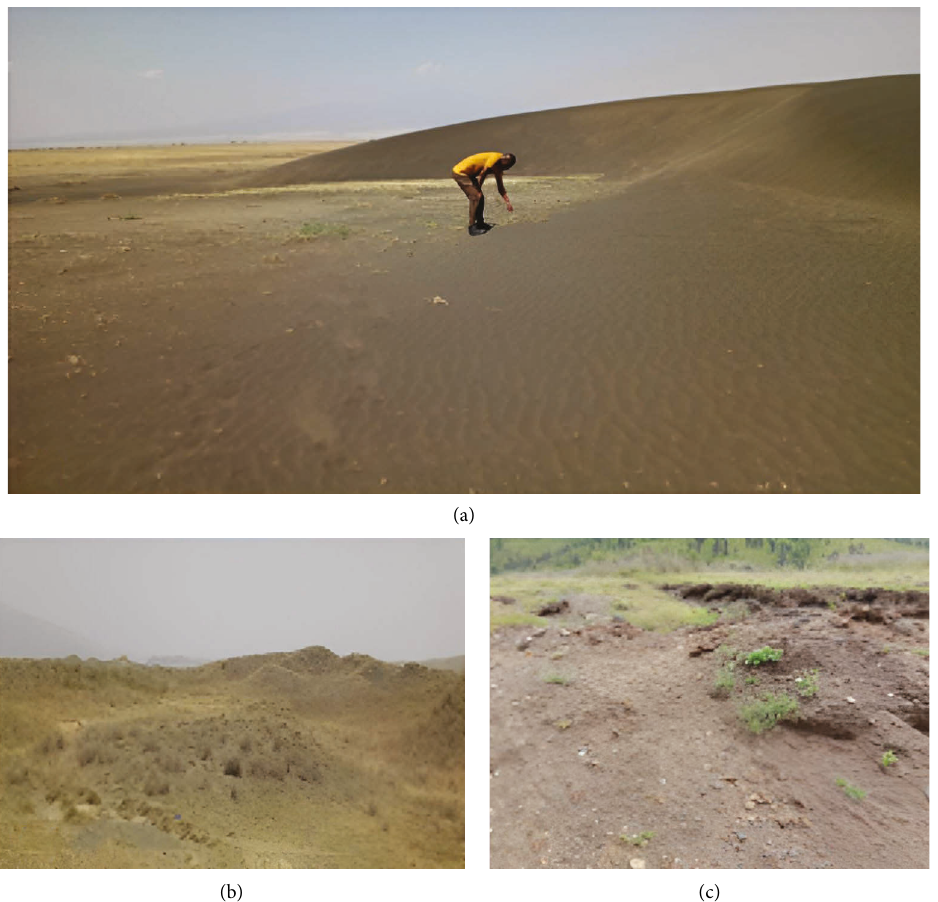
Figure 2: (a) Shifting sands (SSs) near Oldupai Gorge area, (b) Ootun sands (OTSs), and (c) the Ngorongoro Conservation Area (NCA) sampling site (source: field survey photographs by the research team with permission, September